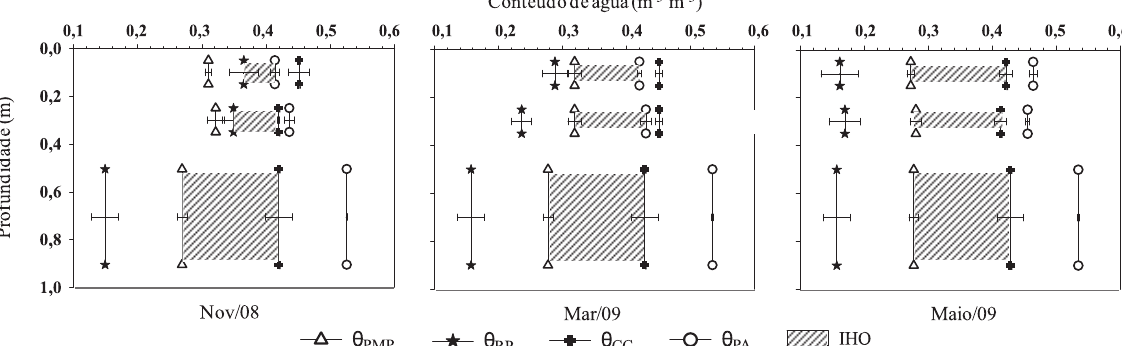
Figura 2. limites inferiores e superiores do intervalo hídrico ótimo (IHo), nos limites críticos de capaci- dade de campo ( q cc ), ponto de murcha permanente ( q PmP ), porosidade de aeração de 0,10 m 3 m -3 ( q Pa ) e resistência do solo à penetração de 2,5 mPa ( q rP ), para o latossolo vermelho-amarelo cultivado com coastcross para fenação, nas profundidades de 0–0,05, 0,20–0,25 e 0,80–0,85 m (Bw), nos meses de novembro de 2008, março de 2009 e maio de